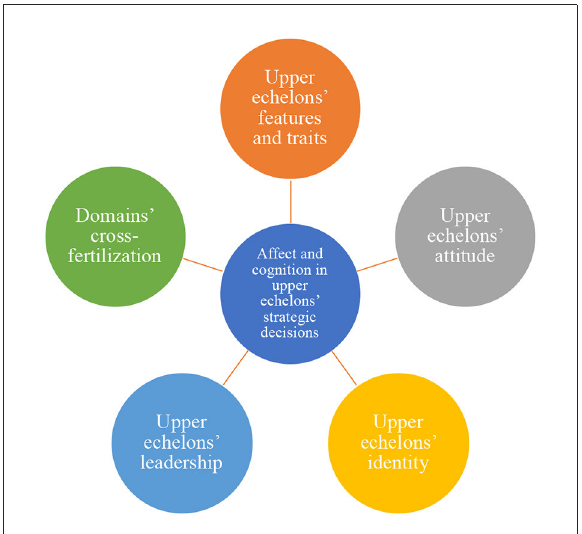
FIGURE1 A synthesis of the crucial directions taken for studying affect and cognition in upper echelons’ strategic decision making.